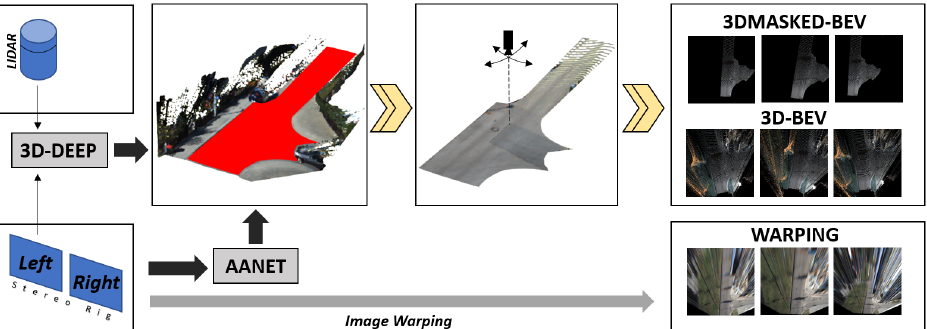
Figure 10. The figure depicts the overall pipeline used to generate the 2D planar images used in this work (apart from the original RGB-left camera). Among them, only the 3DMASKED-BEV uses the LiDAR data. The central part of the image shows the two methods of our Data augmentation scheme , i.e., the 3D-based realistic virtual camera that exploits the 3D point cloud-based reconstruction of the image (from AANET and 3D-Deep networks) and the 2D-based homography that usually generates substantial image